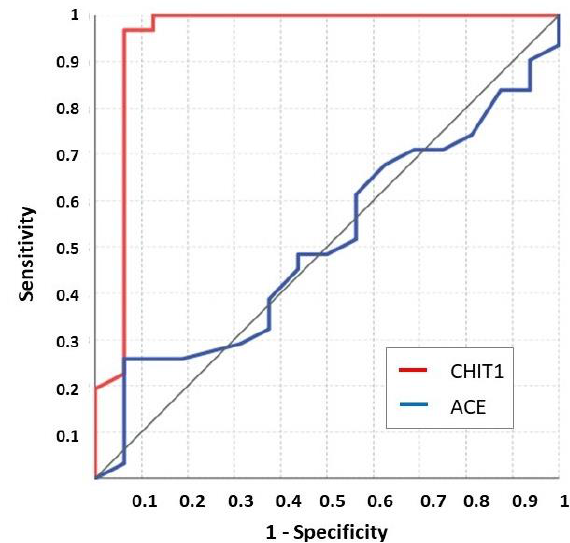
Figure 2. ROC analysis on CHIT1 and ACE values between before and after treatment sarcoidosis